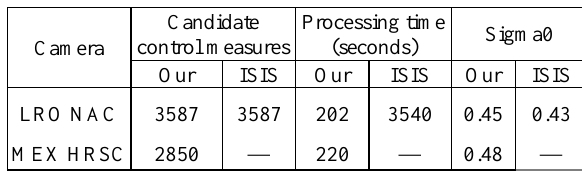
Figure 5. Valid control measures used for bundle adjustment of MEX HRSC images. The black line on h5273 s22 image was introduced at the raw image acquisition period.